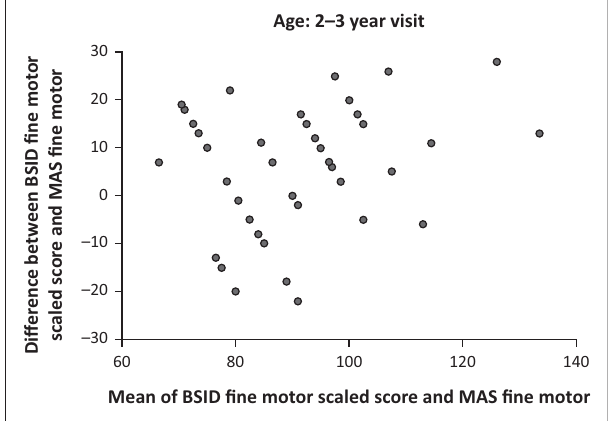
FIG URE 5: Bland–Altman scatter plot illustrating mean difference between Molteno Adapted Scale and Bayley Scales of Infant and Toddler Development- 3rd edition fine motor scores versus Molteno Adapted Scales and Bayley Scales of Infant and Toddler Development-3rd edition fine motor scores at the 1-year visit.